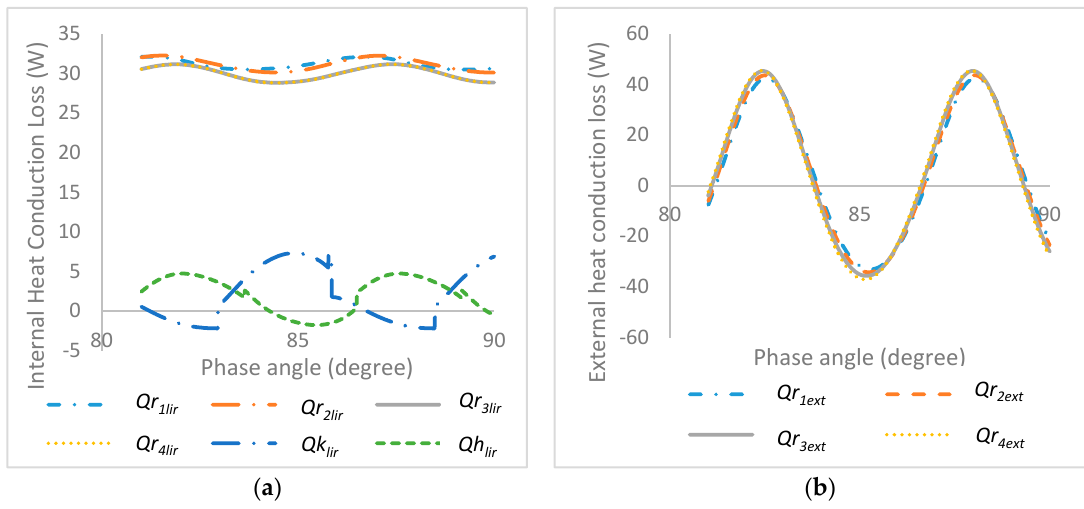
Figure 7. ( a ) Internal heat conduction loss in the heat exchangers against phase angle; ( b ) External heat conduction loss in the regenerator against phase angle.